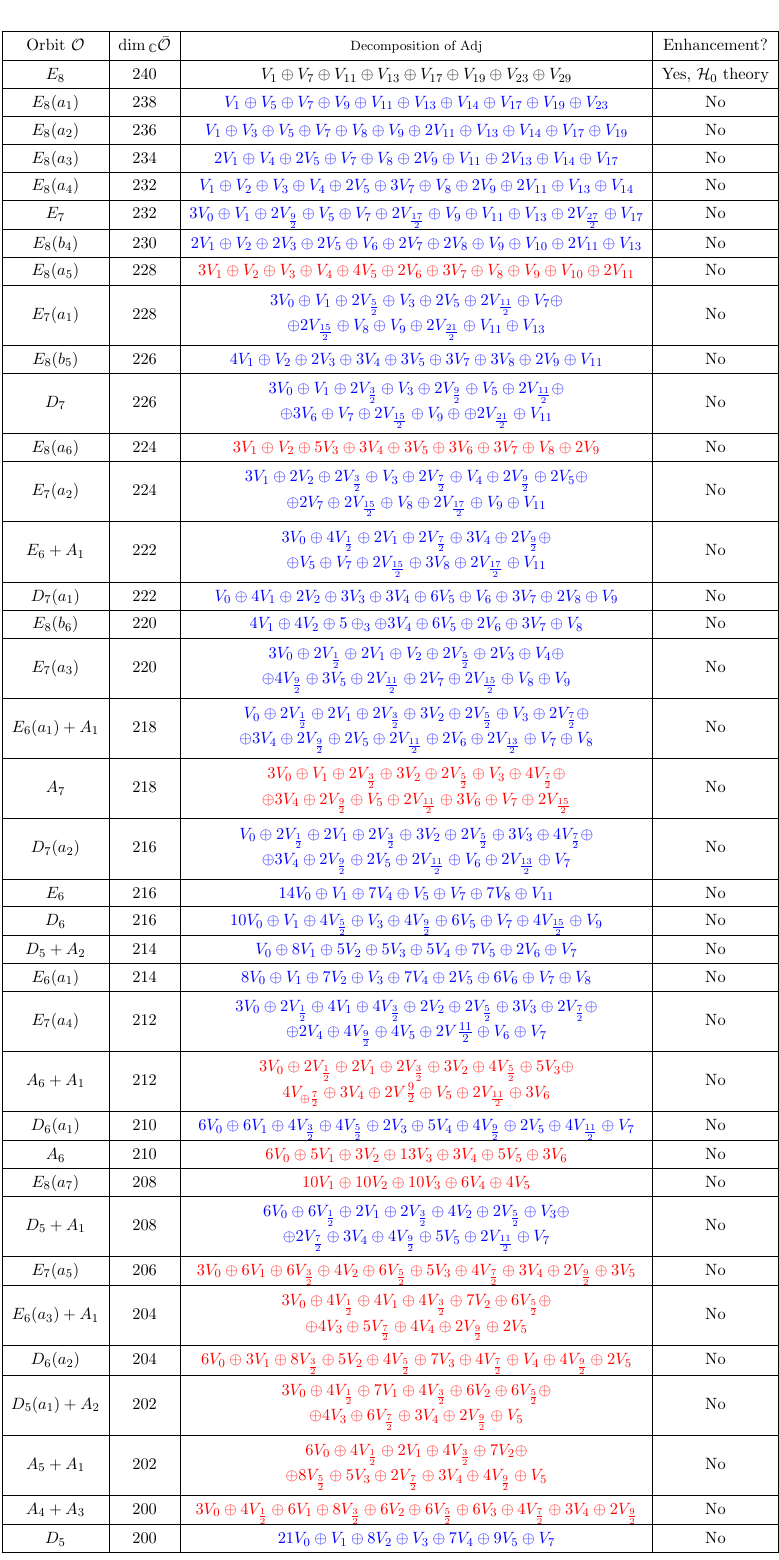
Table 5 . All the orbits or e 8 and their adjoint decomposition. Part 1. Table taken from [56].